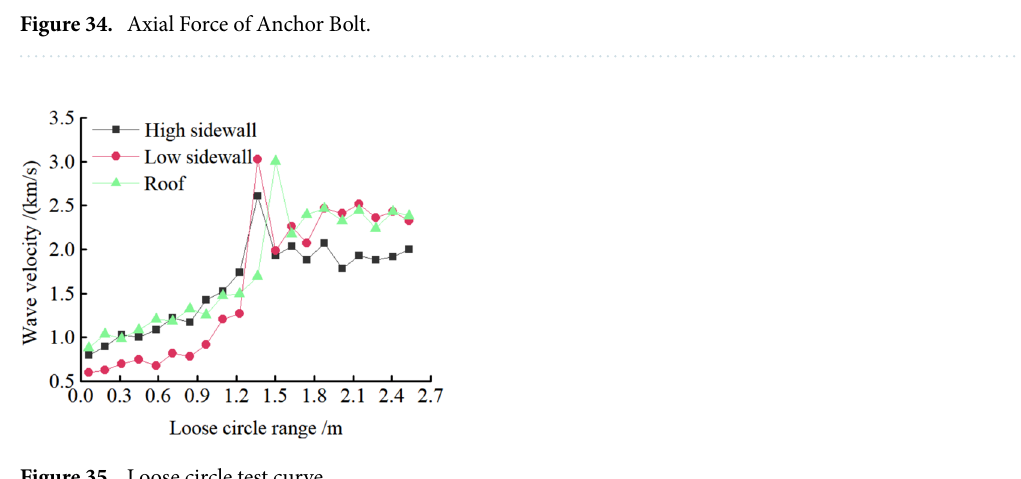
Figure 35. Loose circle test